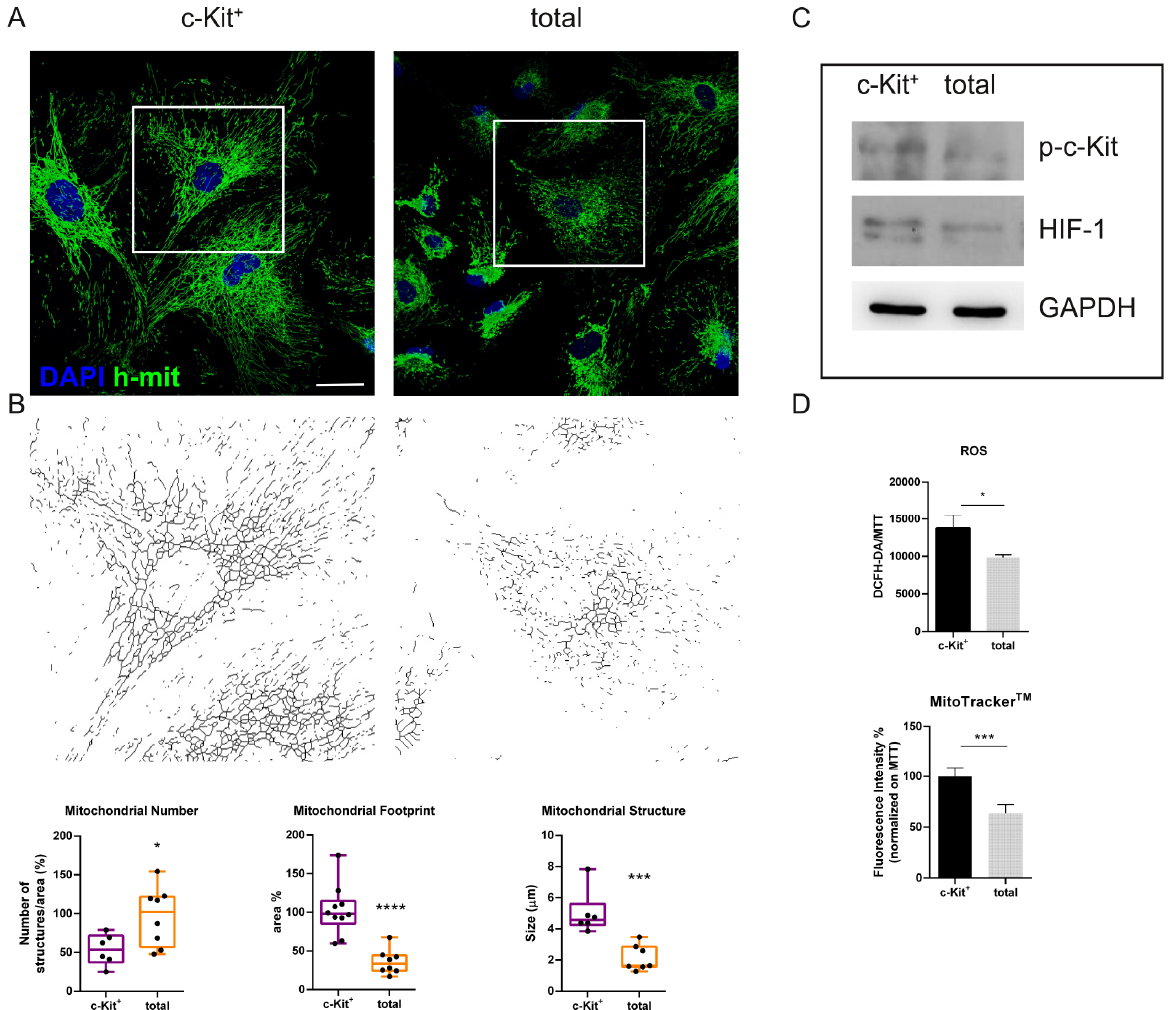
Figure 4. Comparison of mitochondrial morphology and ROS levels. ( A ) Representative immunoflu- orescence images and the relative graphs showing the morphological pattern (number, size, and footprint) of mitochondria in total hAFSCs and c-Kit + cells. Confocal images are superimposed between DAPI (blue) and h-mit (green). ( B ) MiNA analysis has been performed on the skeletonized images rendering shown below in black and white. Scale bar = 10 µ m. **** p < 0.0001; *** p < 0.001; * p < 0.05 = significantly different from c-Kit+ samples. ( C ) Representative images of Western blot analysis of hAFSC samples, revealed with anti-phospho-c-Kit, anti-HIF1 α , and anti-GAPDH, as a loading control. ( D ) Representative graphs showing fluorescence, obtained with probes for ROS (DCFH-DA) and mitochondrial signal (MitoTracker), normalized to MTT viability values of hAFSCs samples. *** p < 0.001; * p < 0.05 = samples significantly